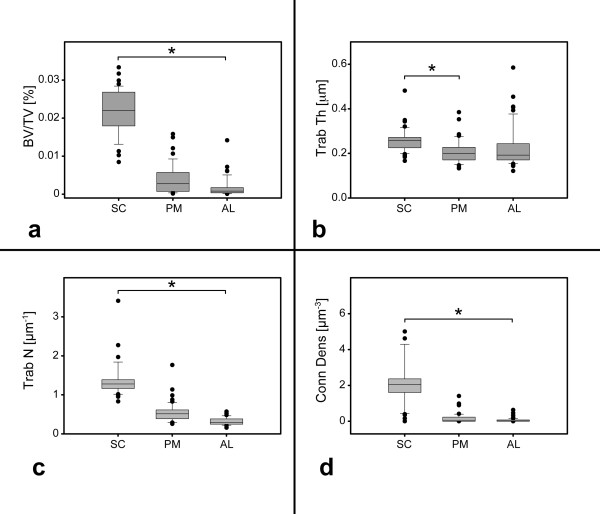
Morphometric parameters of bone quality.a) the ratio bone volume/total volume (BV/TV) is given as percentage [%]. Data for the subchondral region are labeled as SC, followed by the posteromedial portion PM and the anterolateral AL. b) presents data for trabecular thickness (Trab Th) in μm. c) presents data for trabecular number (Trab N), given in [μm-1]. In d) data for connectivity density (Conn Dens) are presented in [μm-3]. Data are given as boxplots, * p < 0.05.